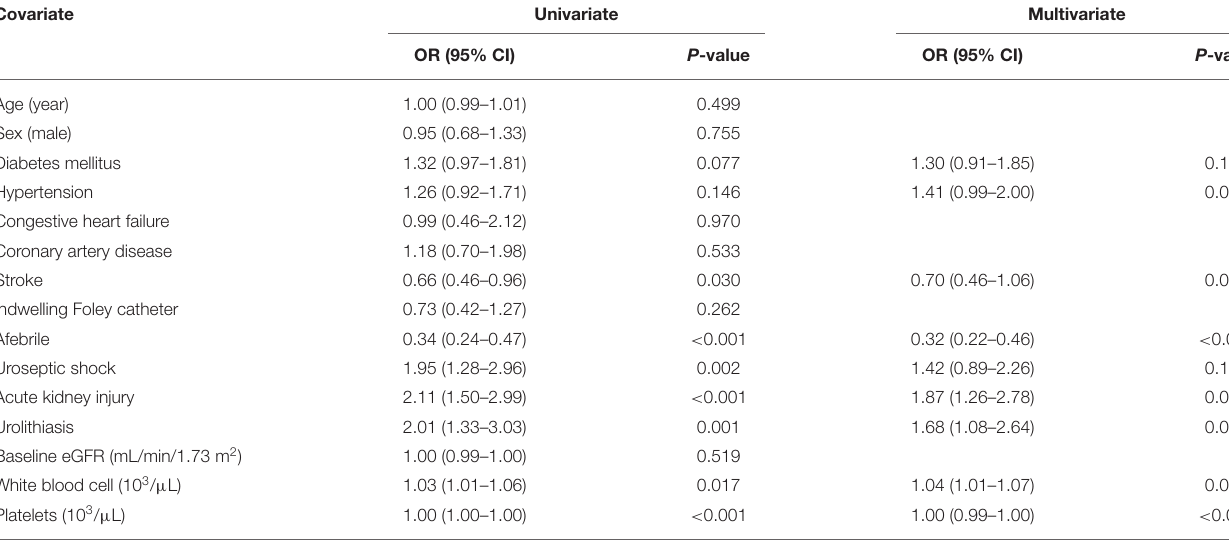
TABLE 4 | Univariate and multivariate logistic regression analyses of factors related to bacteremia in patients with urinary tract infection. Covariate Univariate Multivariate OR (95%